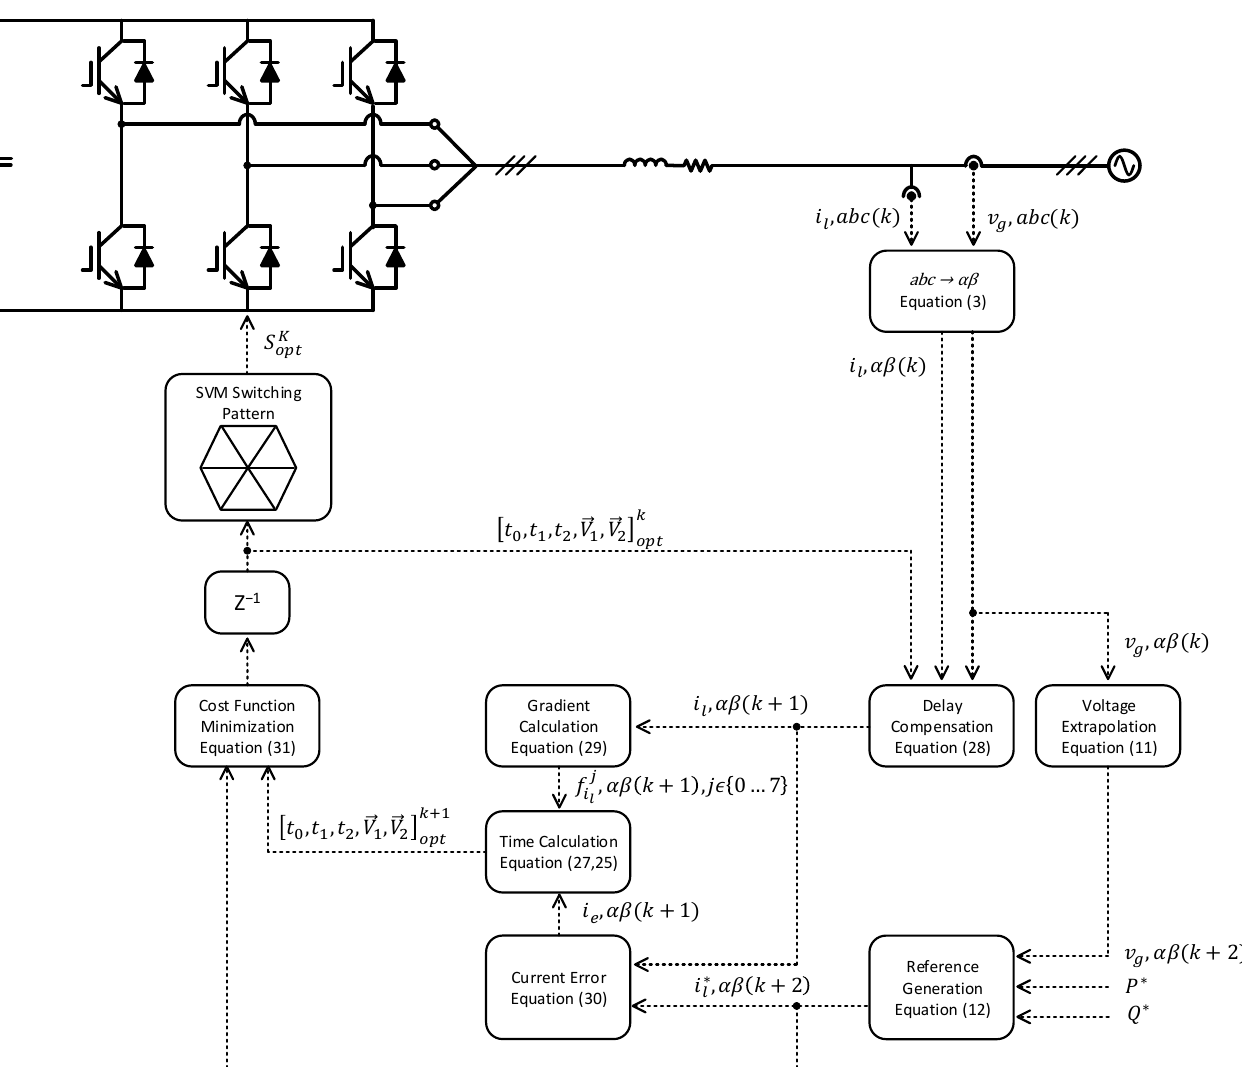
Figure 9. Block diagram of three-phase two-level VSI with OSS-MPC control. To select the optimum application times of the switching vectors for each T s , the Lagrange multipliers method, without restrictions, is applied. The sum of the quadratic current future error is minimized by applying Equations (23) and (24).